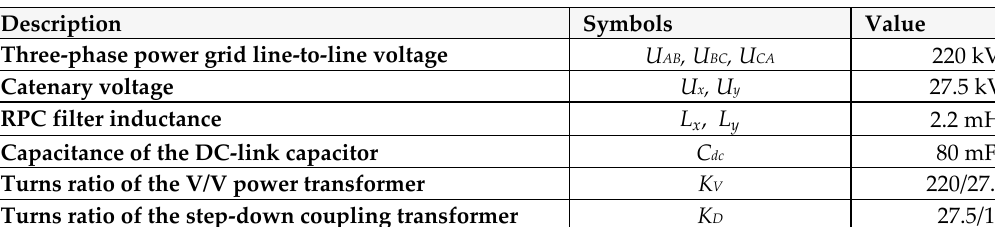
Table 14. Parameters of the FB-RPC simulation model.